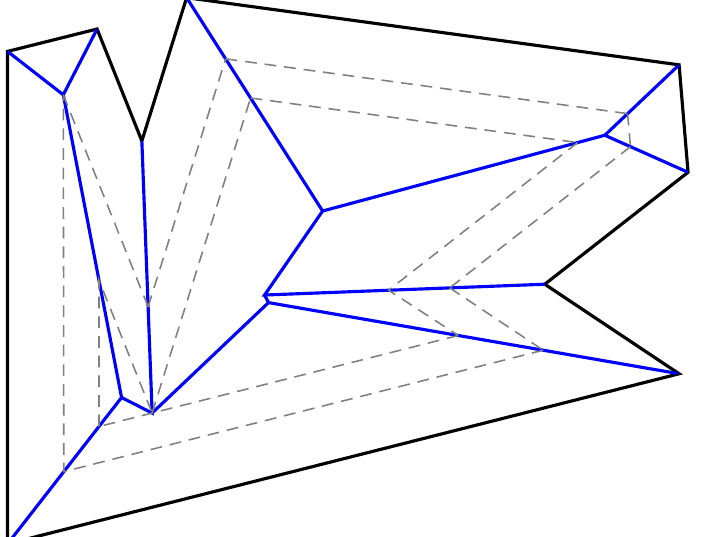
Figure 1. Straight skeleton of a polygon. The dashed polygon offsets indicate its shrinking process.